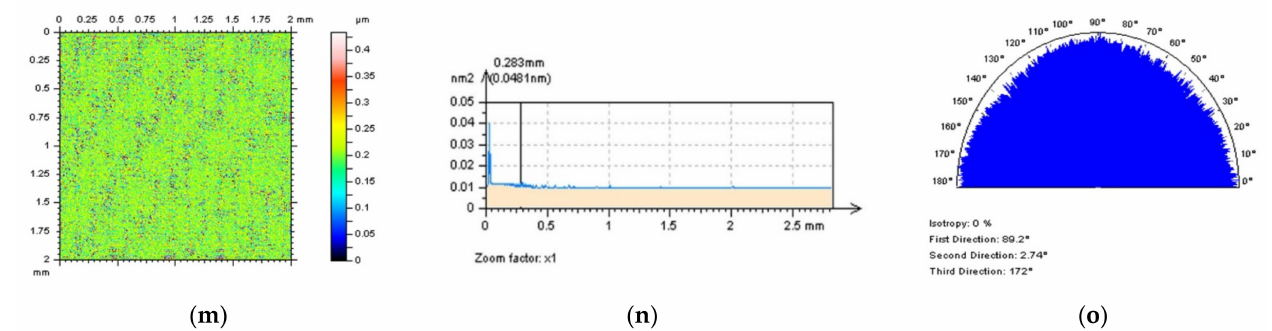
Figure 13. Countour map plots ( a , d , g , j , m ), PSDs ( b , e , h , k , n ) and texture direction ( c , f , i , l , o ) graphs of the HFNS defined by the: Gaussian ( a – c ), robust Gaussian ( d – f ), median ( g – i ), spline ( j – l ) and FFTF ( m – o ) filter, cut-off = 0.015 mm.